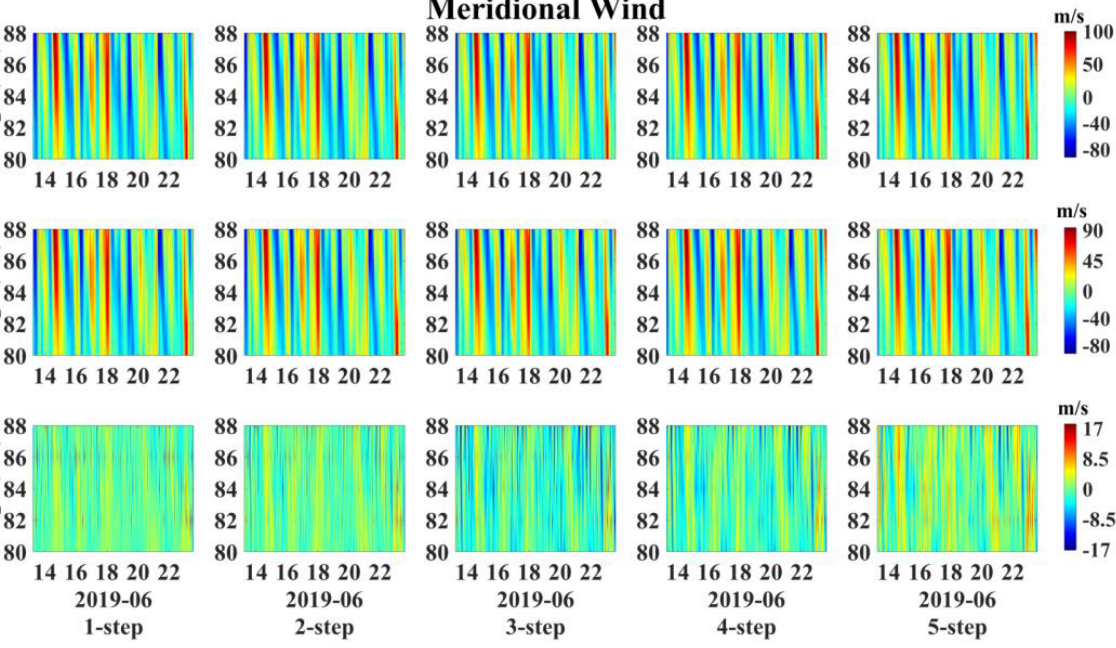
Figure 6. VMD – PSO – LSTM meridional wind 80 – 88 km prediction results from 14 – 23 June 2019. Figure 6. VMD–PSO–LSTM meridional wind 80–88 km prediction results from 14–23 June 2019. From top to bottom are observations, predicted value and absolute errors. From top to bottom are observations, predicted value and absolute